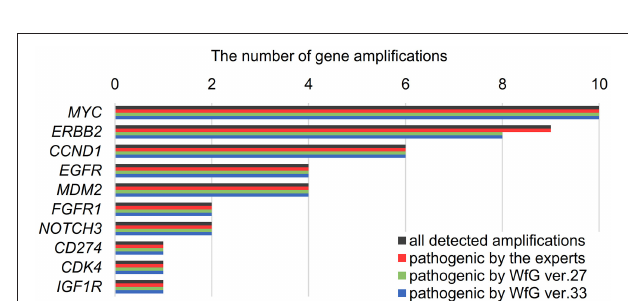
FIGURE 3 | List of all gene amplifications and pathogenic amplifications detected by the expert panel, WfG ver. 27 and WfG ver.33. The number of all gene amplifications detected, the number of pathogenic amplifications identified by experts, the number of pathogenic amplifications identified by WfG ver. 27, and the number of pathogenic amplifications identified by WfG ver. 33 are